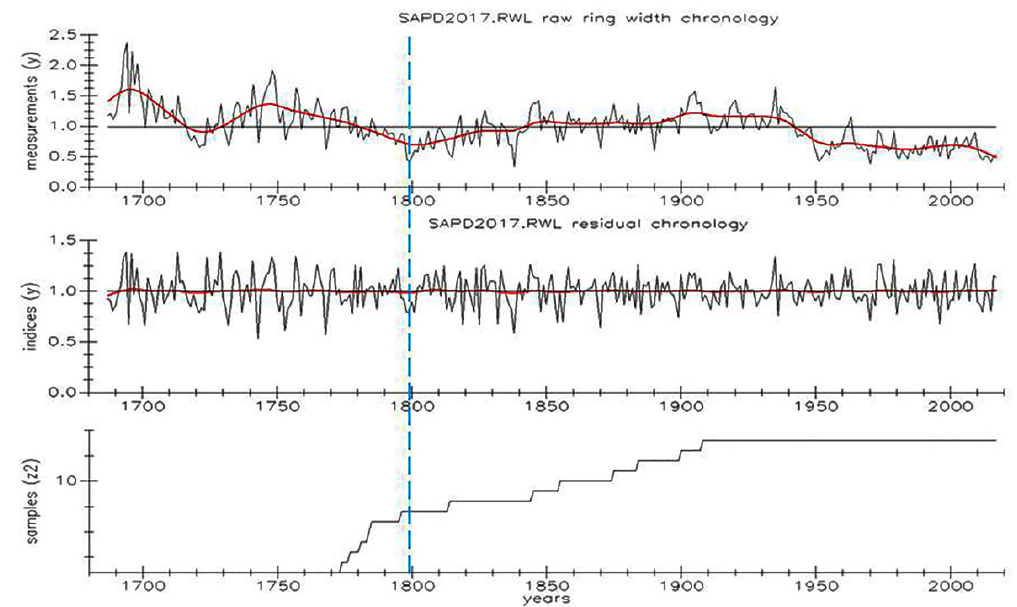
Figure 3. The chronology and sample depth of P. densiflora from Mt. Seorak (dotted line is SSS ≥ 0.85).